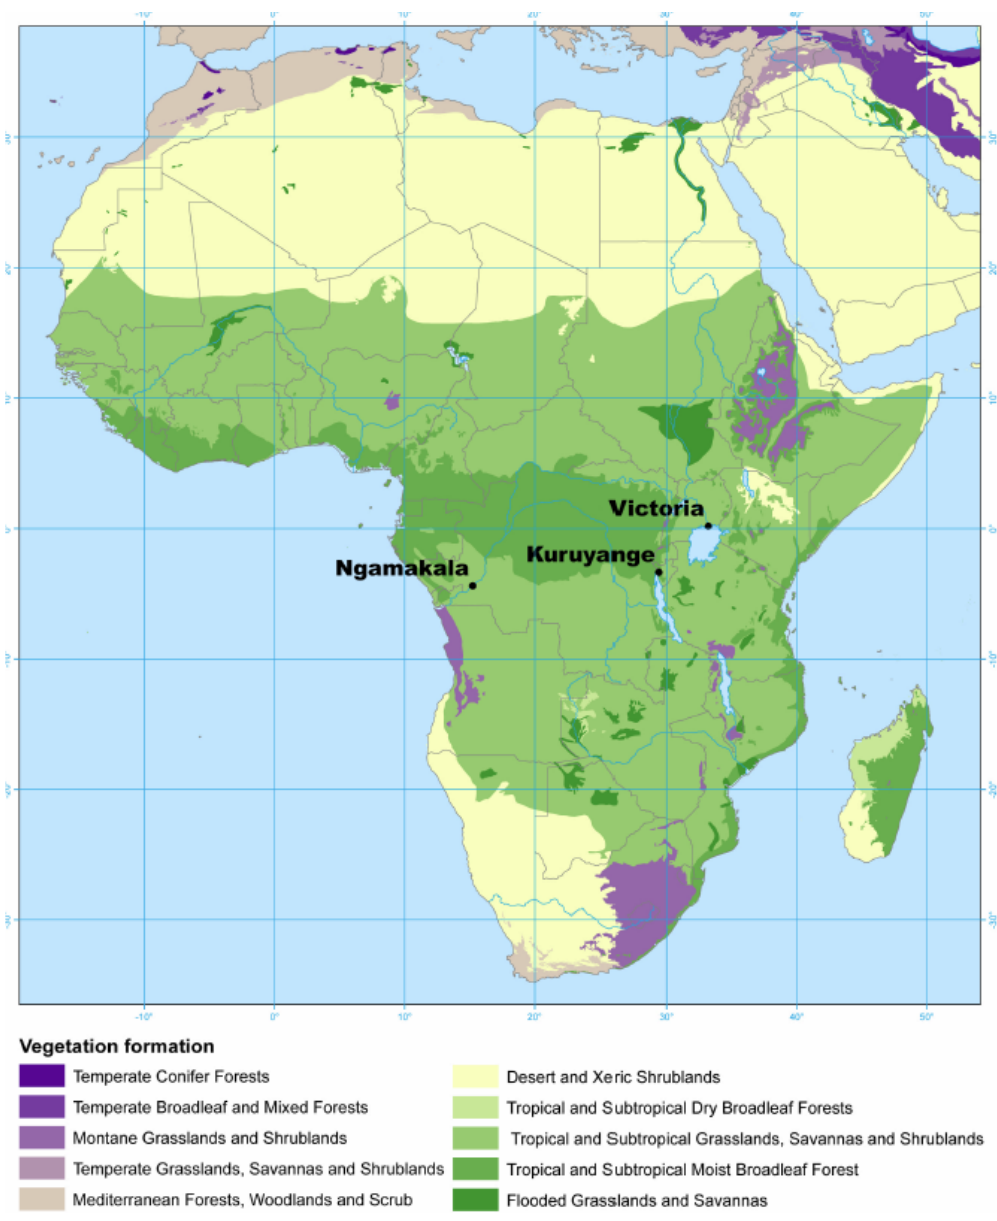
Fig. 1. Sites location and current observed vegetation